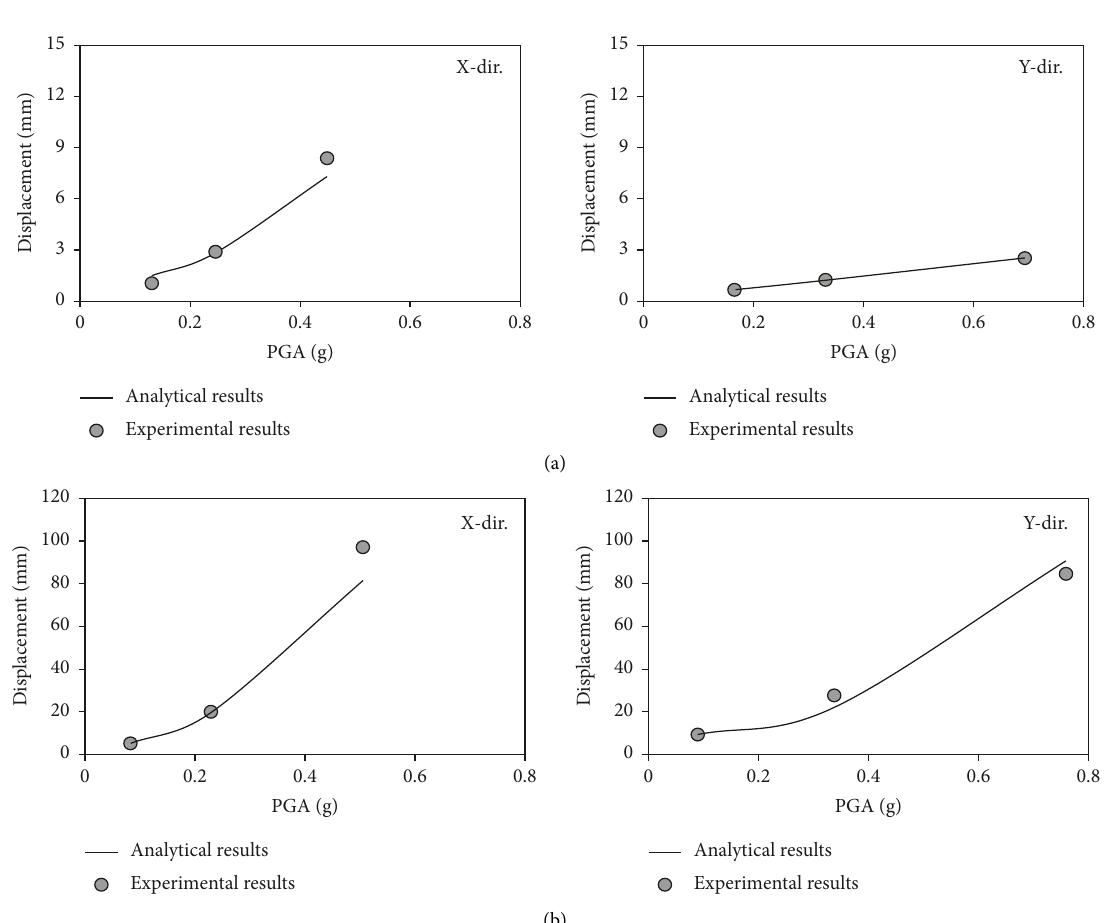
Figure 20: Displacement versus PGA at the top (cooling system) of the UPS specimens, as obtained from the experimental and analytical results. (a) Series A. (b) Series